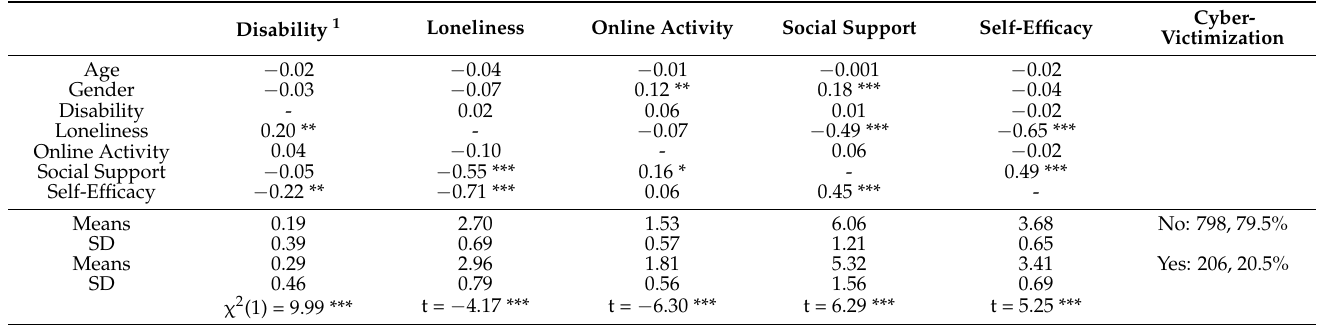
Table 1. Correlations between research variables and descriptive